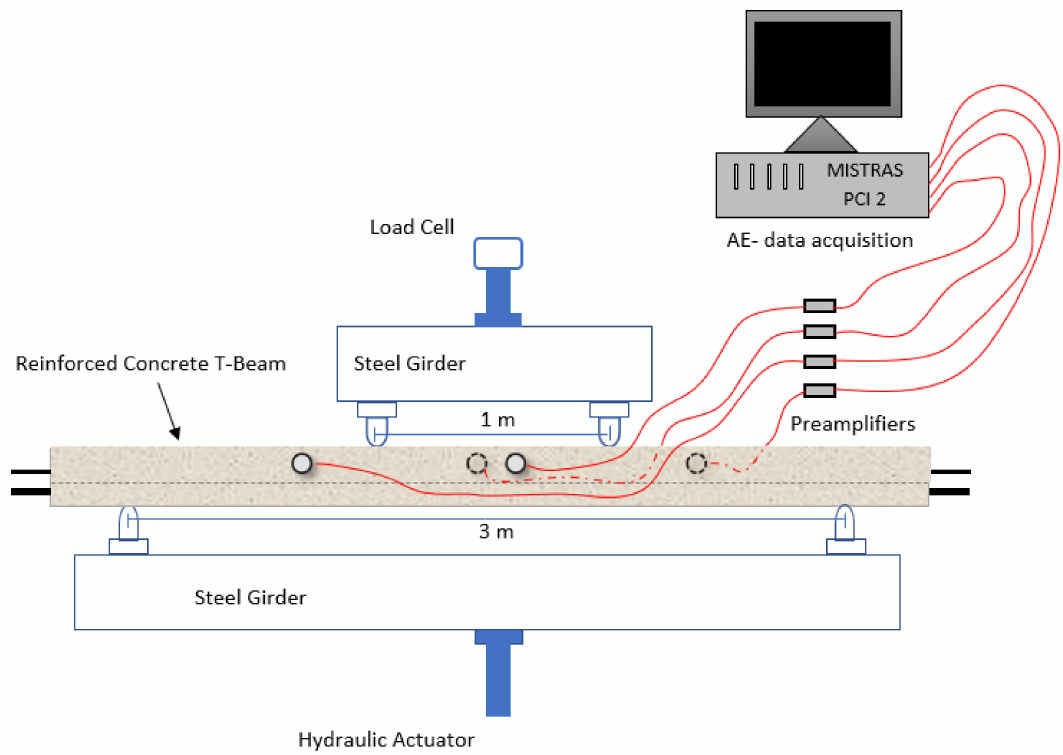
Figure 5. Reinforced concrete T-beam subjected to four-point bending and acoustic